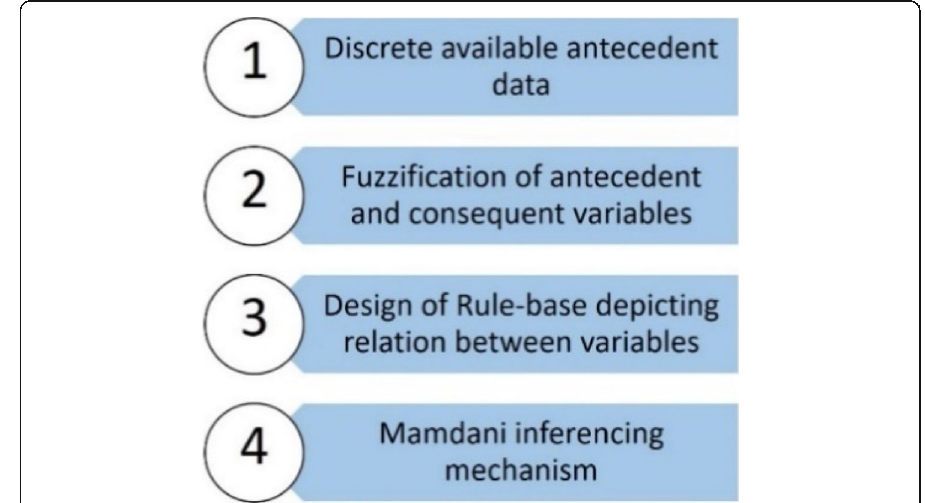
Fig. 3 Block diagram illustration of fuzzy system building